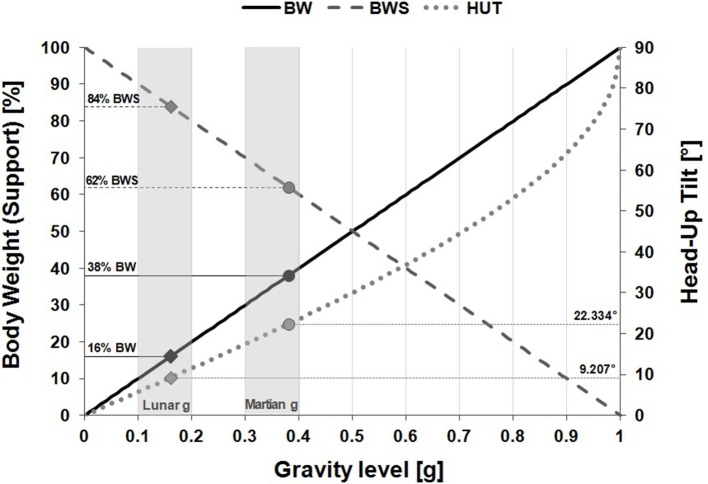
Various levels of gravity expressed in different units. The exact value for Lunar gravity is 0.16 g or 9.21° HUT or 16% BW or 84% BWS. The exact value for Martian gravity is 0.38 g or 22.33° HUT or 38% BW or 62% BWS. The ranges that were considered acceptable for Lunar- and Martian gravity in the present study are shown in gray. The exact values for Lunar and Martian gravity and each unit are depicted through solid diamonds and circles. BW, Body weight (in %); BWS, Body weight support (in %); HUT, Head-up tilt (in degree).